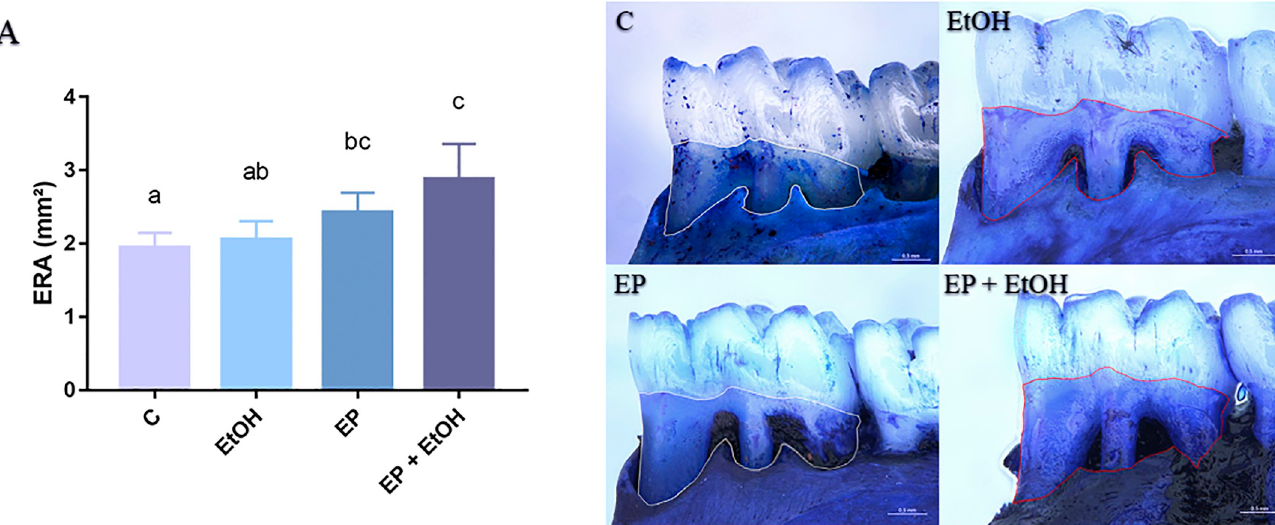
Fig 2. Exposed root area in mm 2 in all experimental groups. (A) Results are expressed as mean ± standard error of the number of exposed root area. On the right, representative photomicrographs of hemi-mandibles of the (C) Control group; (EtOH) Ethanol binge drinking group; (EP) Experimental periodontitis group and (EP + EtOH) Experimental periodontitis and Ethanol group. EP+EtOH group presented the highest ERA identified among the groups. Same letters indicate no significant differences between groups (P < 0.05, ANOVA followed by Tukey post hoc test). Scale bar: 0.5mm.